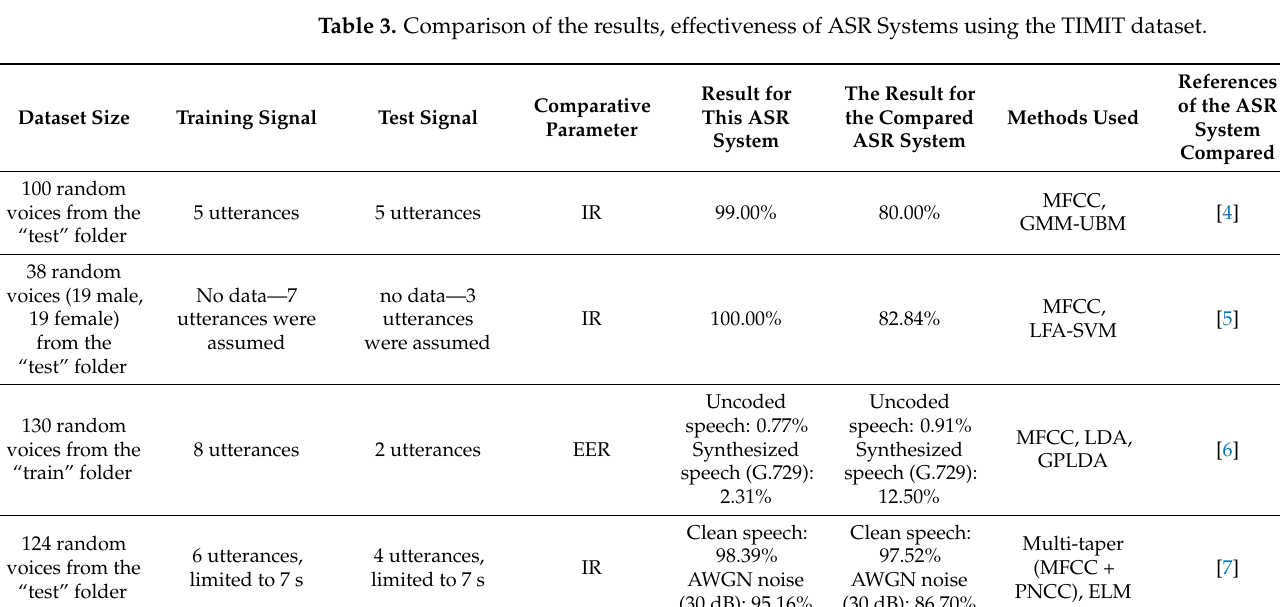
Table 3. Comparison of the results, effectiveness of ASR Systems using the TIMIT dataset.